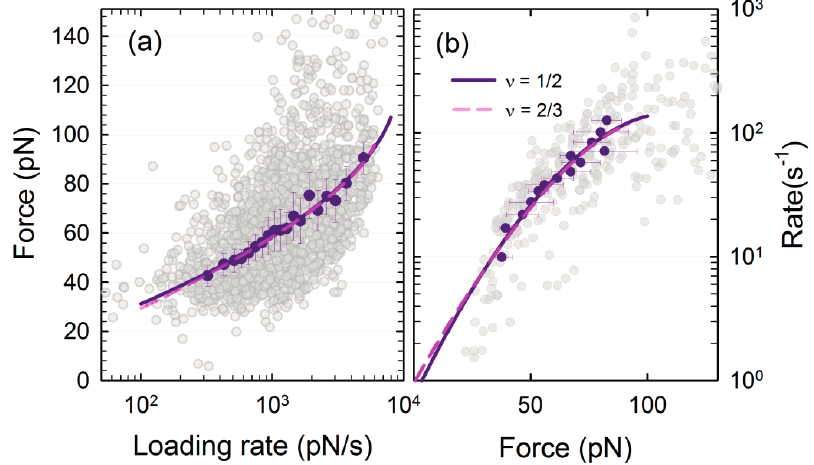
Figure 7. Force-distance retraction curves obtained for pig gastric mucin covalently attached to mica and alginates covalently attached to the AFM tip. The force distance data were collected in aqueous solution on a high-precision mapping stage. The measurements were conducted in buffered aqueous solution (25 mM Hepes buffer, 150 mM NaCl, pH 6.9). The galleries of force distance curves are shown for the mucin interacting with alginates with F G = 0.65 ( a ); and F G = 0.38 ( b ). Data are shown only for the retraction directions from the surface, and are shifted in the vertical direction for better visibility.